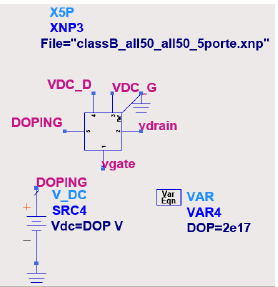
Figure 11. Left: Xpar with extra port DOPING used for doping interpolation in the Xpar file. In this example a 4-port device component (two DC and 2 RF ports) becomes a 5-port for doping- dependent